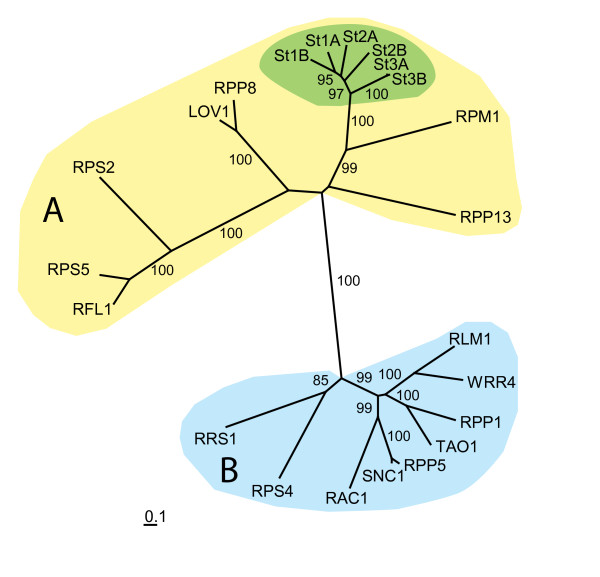
Un-rooted maximum-likelihood phylogram inferred from nucleotide binding (NB) and leucine rich repeat (LRR) domains, of six resistance proteins to S. turcica (St) in sorghum, compared with Arabidopsis NB-LRR resistance proteins with known function. LR-ELW values above 75% are shown. A. NB-LRR resistance proteins with a coiled-coil (CC) domain at the N-terminal end. B. NB-LRR resistance proteins with a Toll/Interleukin-1 receptor (TIR) at the N-terminal end. Units indicate substitutions/site. R-proteins used are listed in Additional file 4.